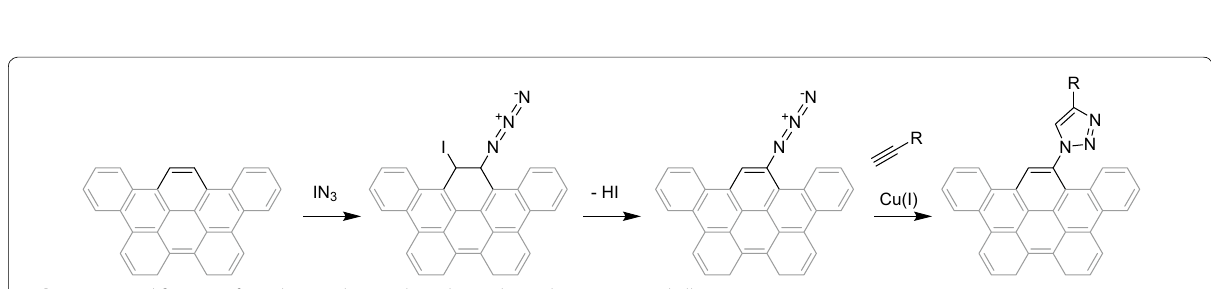
Scheme 2 Modification of graphitic carbon with azides and coupling to terminal alkynes